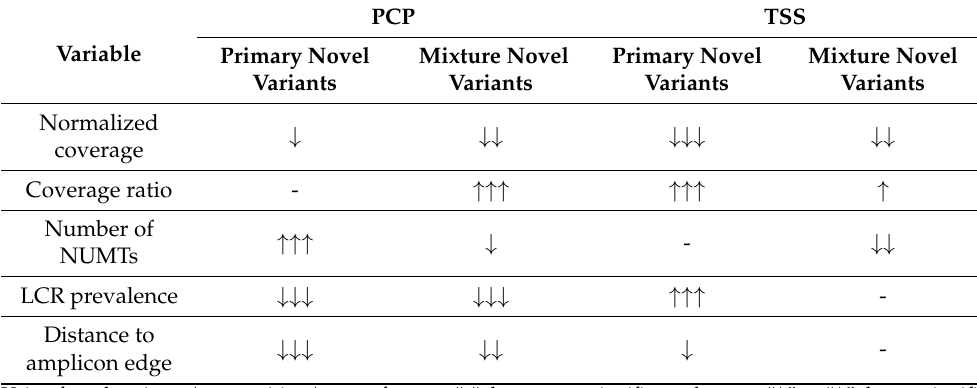
Table 1. Novel variants (false positives): Summary characteristics in the mutserve variant calling method